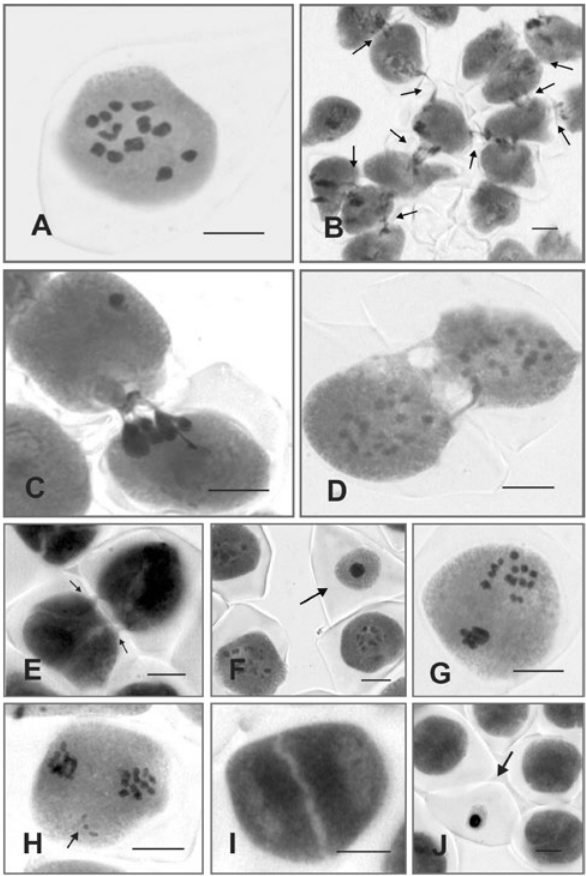
Figure 3. Meiosis in Castilleja arvensis . A) Diakinesis with 12 biva- lents; B) Cells with multiple cytomictic channels in pachytene; C) Donor PMC transferring almost all the chromatin to a neighbor PMC; D) Two cells in diakinesis connected by 3 cytomictic chan- nels; E) Cytomictic channels between tetrads; F) Small-sized meio- cytes with a small nucleus during the division I; G) MII showing a plate with 14 chromosomes; H) MII showing chromosomes discon- nected from equatorial plate; I) Dyad; J) small-sized meiocytes with a small nucleus at the end of the division II. Scale = 10